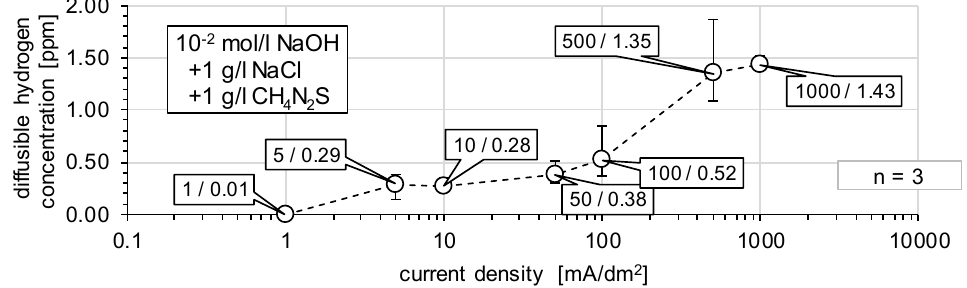
Figure 9. Influence of current density on hydrogen absorption.